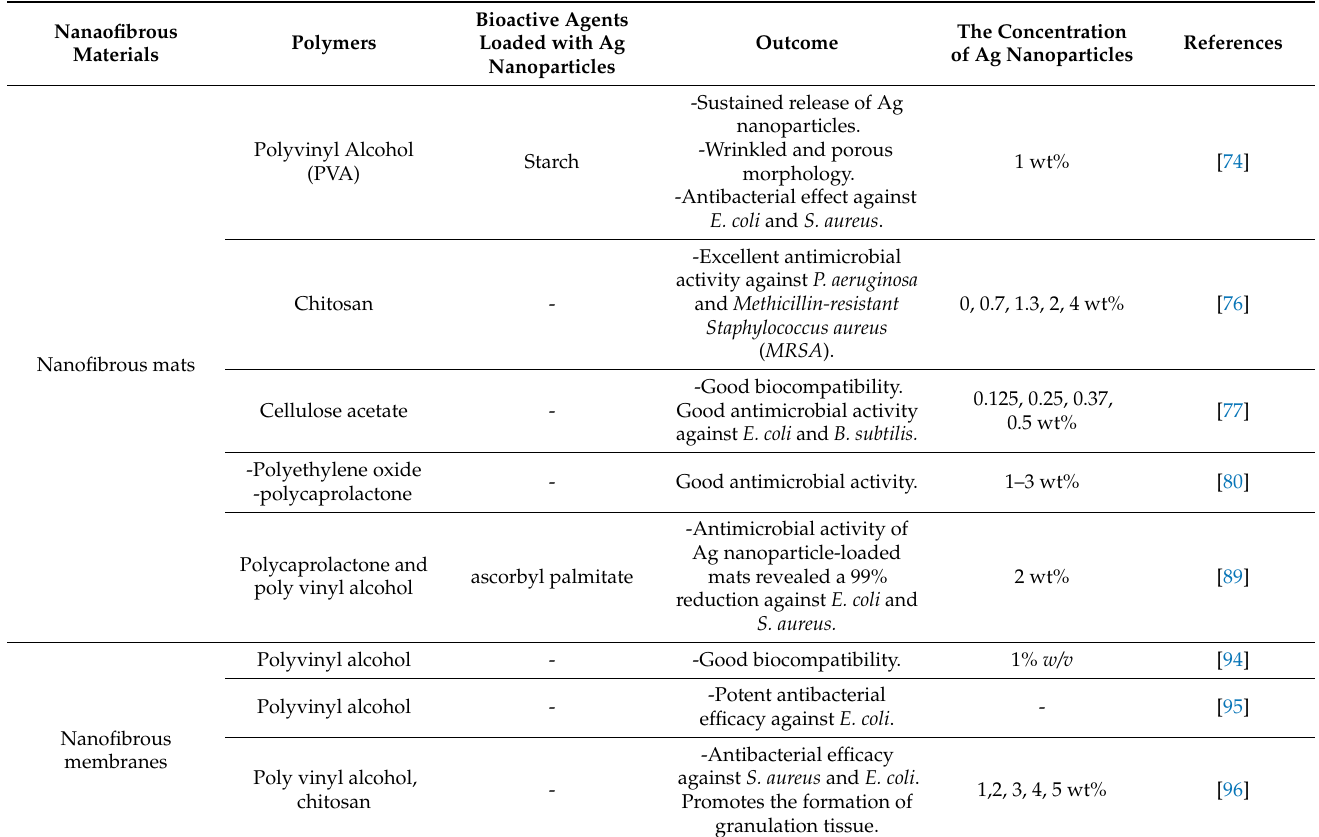
Table 2. Some nanaofibrous materials reported as potential wound